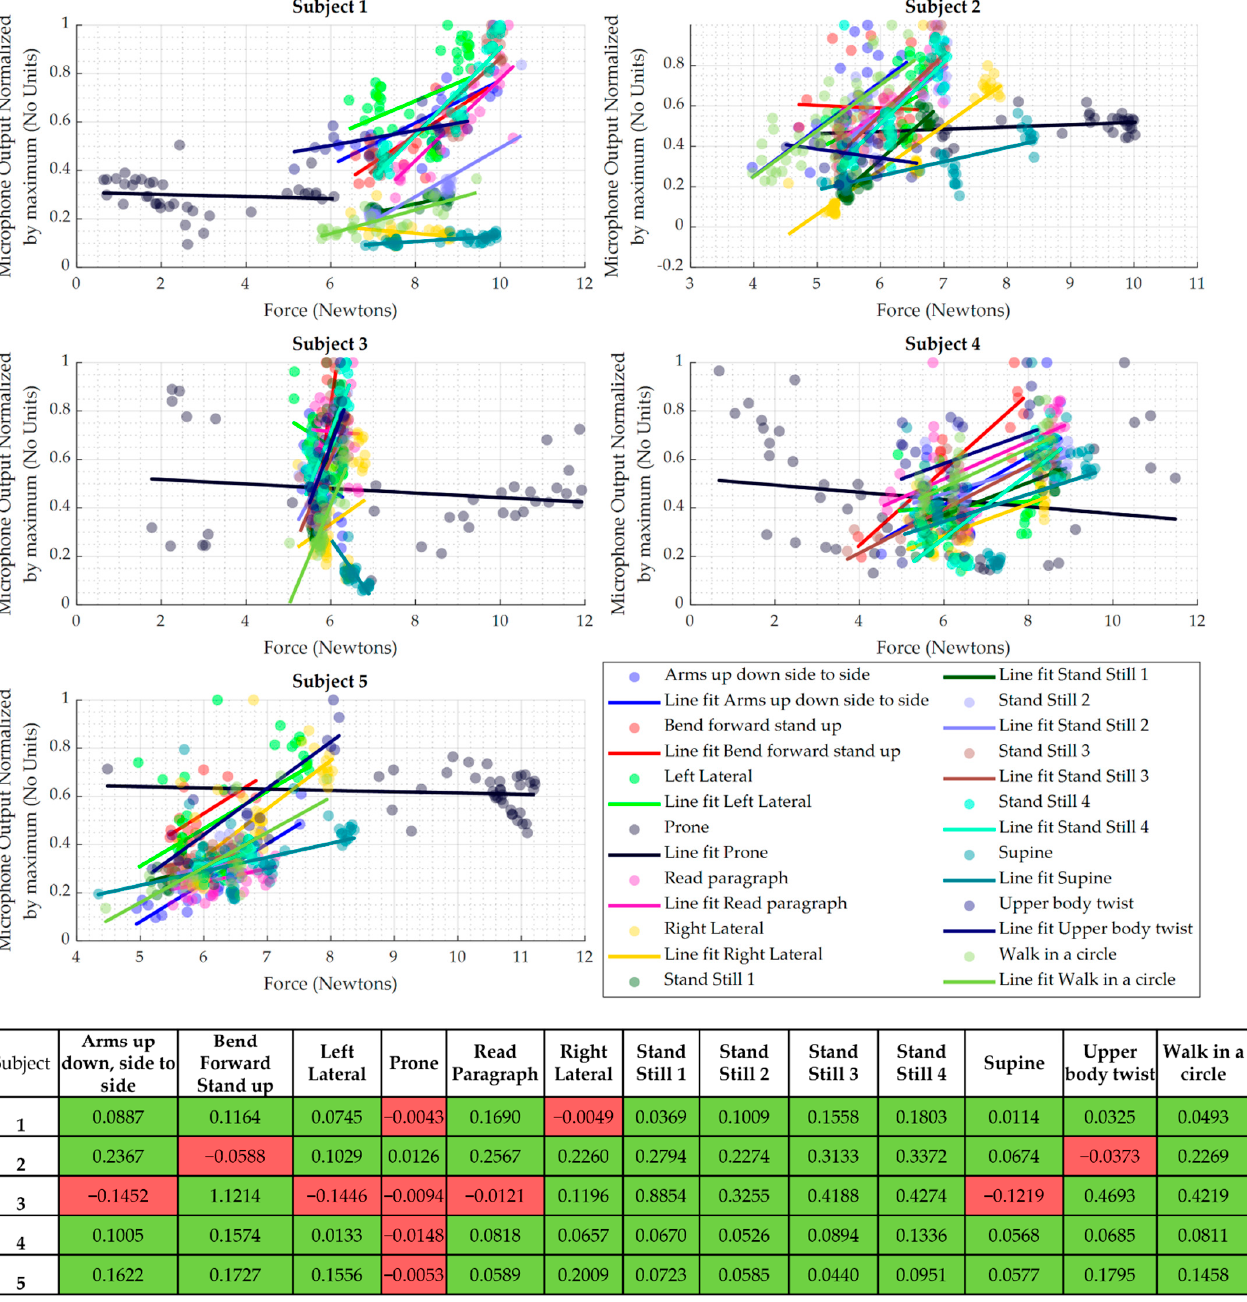
Figure 12. WPAS RMS force vs. RMS of heart sound amplitudes across activities for each subject. The consistent increase in the RMS amplitudes of heart sounds with RMS of force measured by WPAS is observed for all Stand Still activities (1 through 4) and for walking in a circle. However, the results from the other activities are inconsistent. The slopes of the line fits are not strictly positive for activities other than standing still and walking in a circle. This observation suggests that there may be differences in the relationship between force RMS and heart sound amplitude RMS introduced by confounding factors. One confounding factor may be differences in subject body habitus and the movements introduced by differences in body